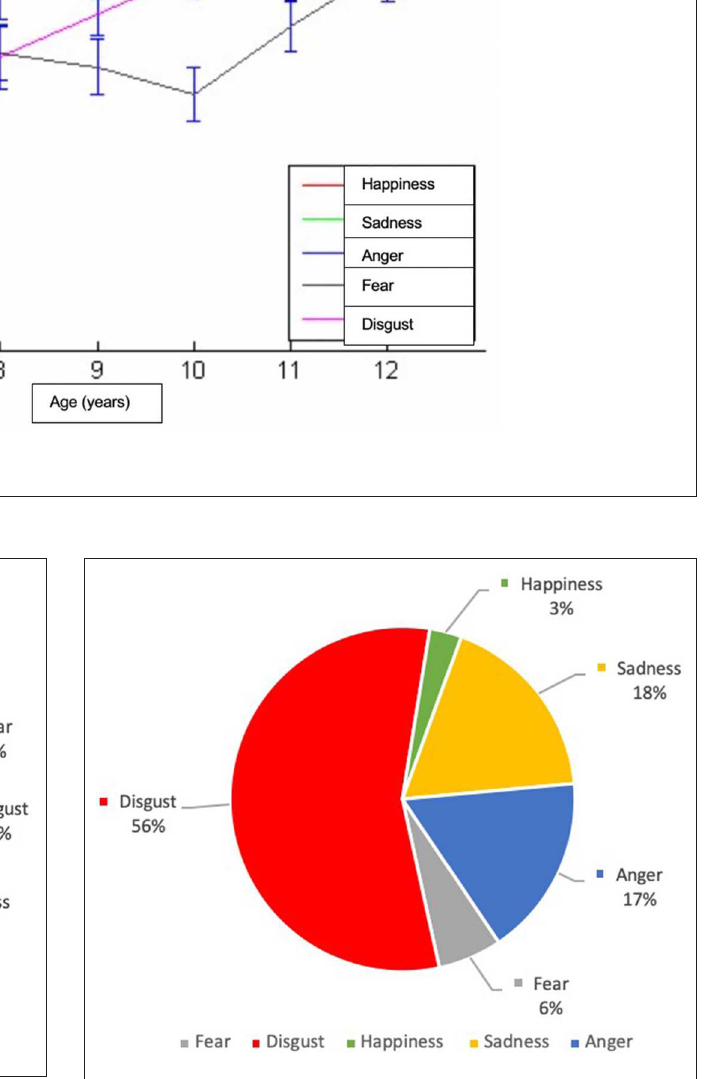
FIGURE 9 | Reactive